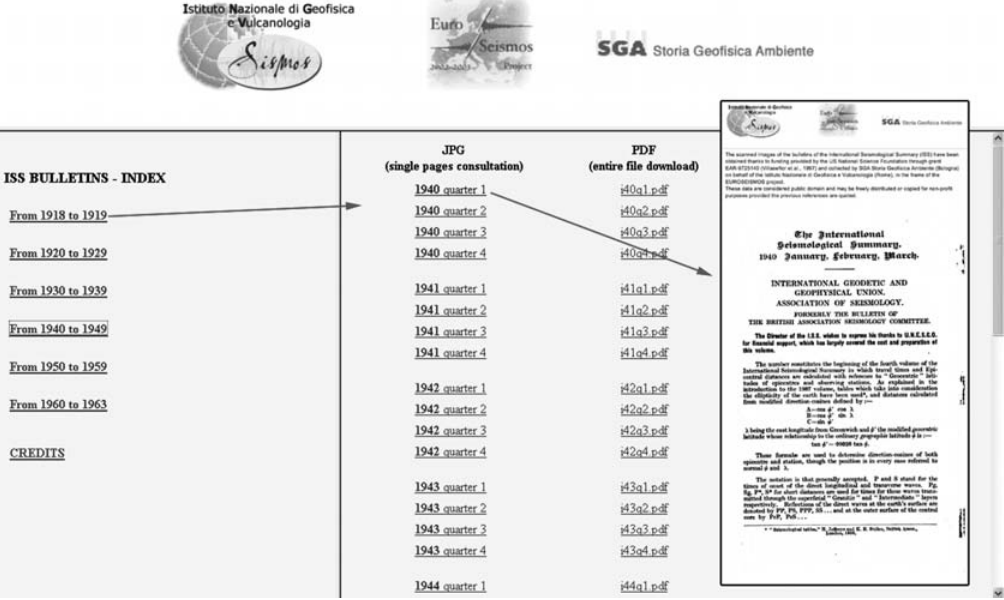
Fig. 17. Section of the ES web site in which it is possible to consult the ISS bulletins from 1918 to 1963 page by page and download them wholly in